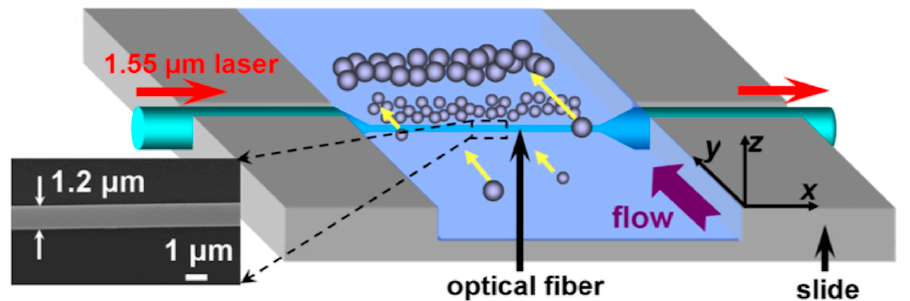
Figure 15. Schematic diagram for particle separation in fluidic flow by an optical fiber. The inset shows the scanning electron microscope image of a 1.2 µ m optical fiber